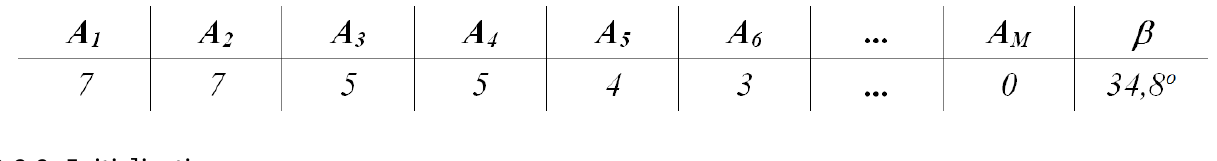
Figure 9. Individual with real coding used in GA-MMC